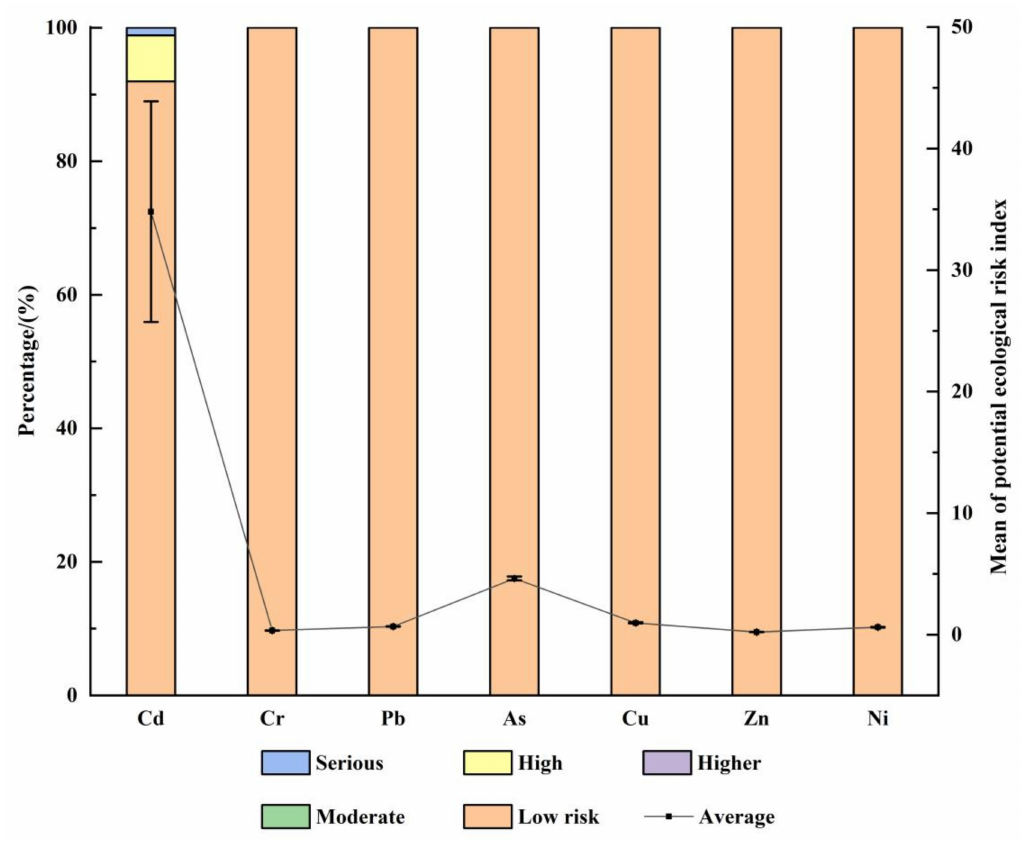
Figure 5. The results of the potential ecological risk index of heavy metals in the surface soil around Qinghai